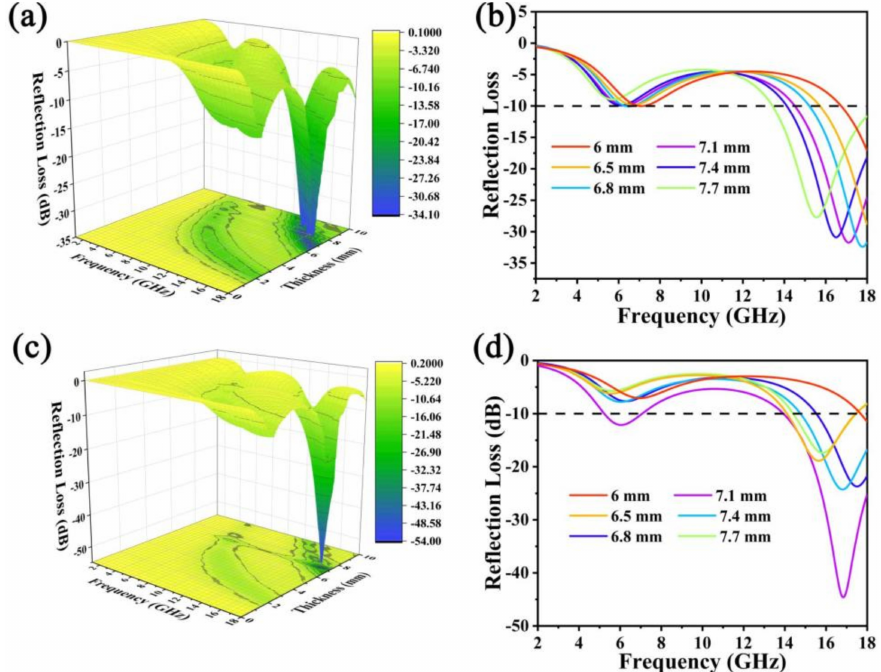
Figure 4. The 3D reflection loss map of ( a ) NMO; ( c ) NCMO. Reflection loss curves of ( b ) CNMO; ( d )